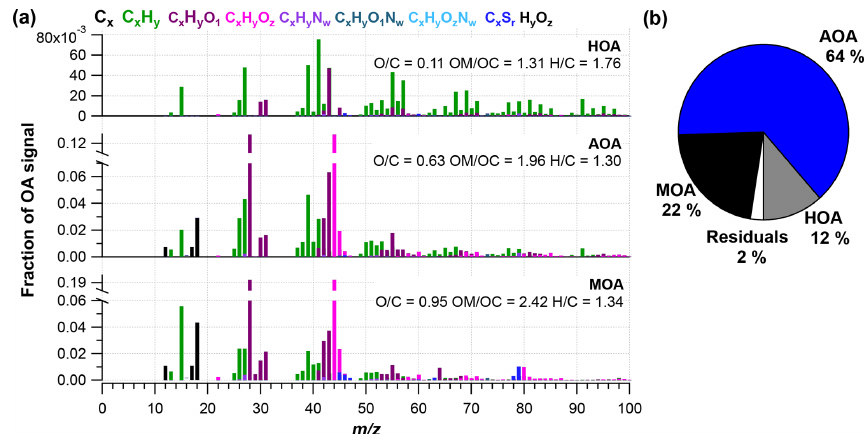
Figure 2. (a) High-resolution mass spectra of PMF factors, including hydrocarbon-like organic aerosol (HOA), Arctic haze organic aerosol (AOA) and marine organic aerosol (MOA), and (b) the factor share of ambient mass concentration. O / C, OM / OC and H / C ratios are presented for each